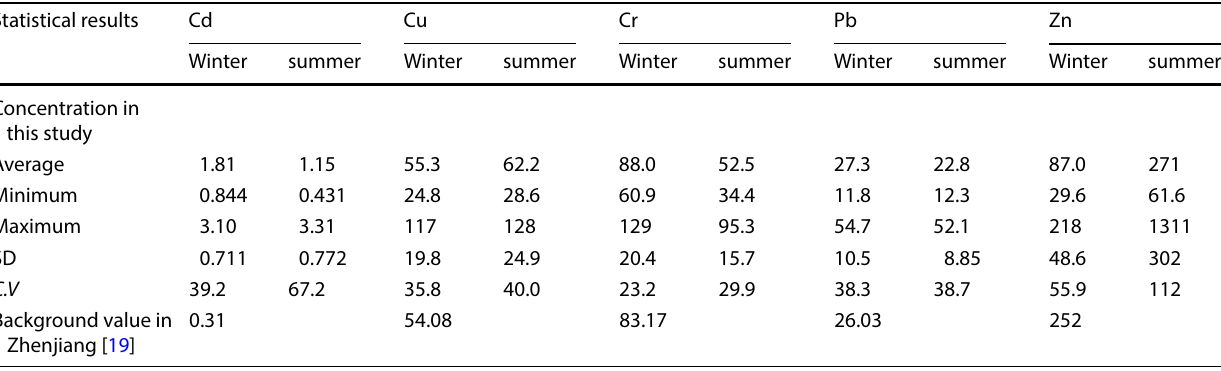
Table 1 Statistical results of the heavy metals in the surface sediment (unit: mg/kg) Statistical results